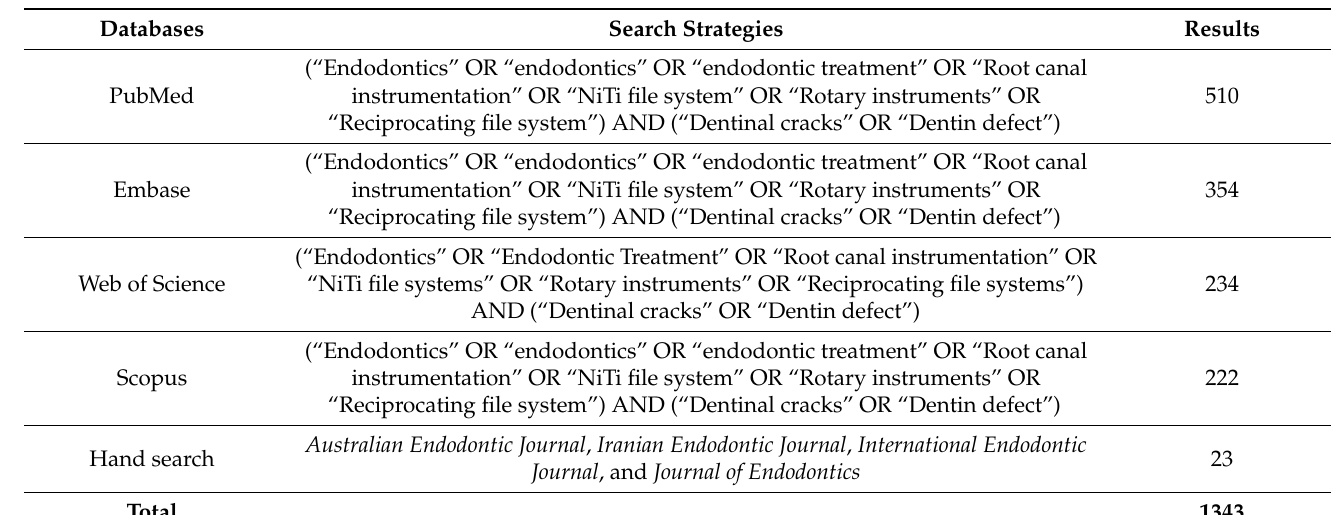
Table 1. Sources of information and search